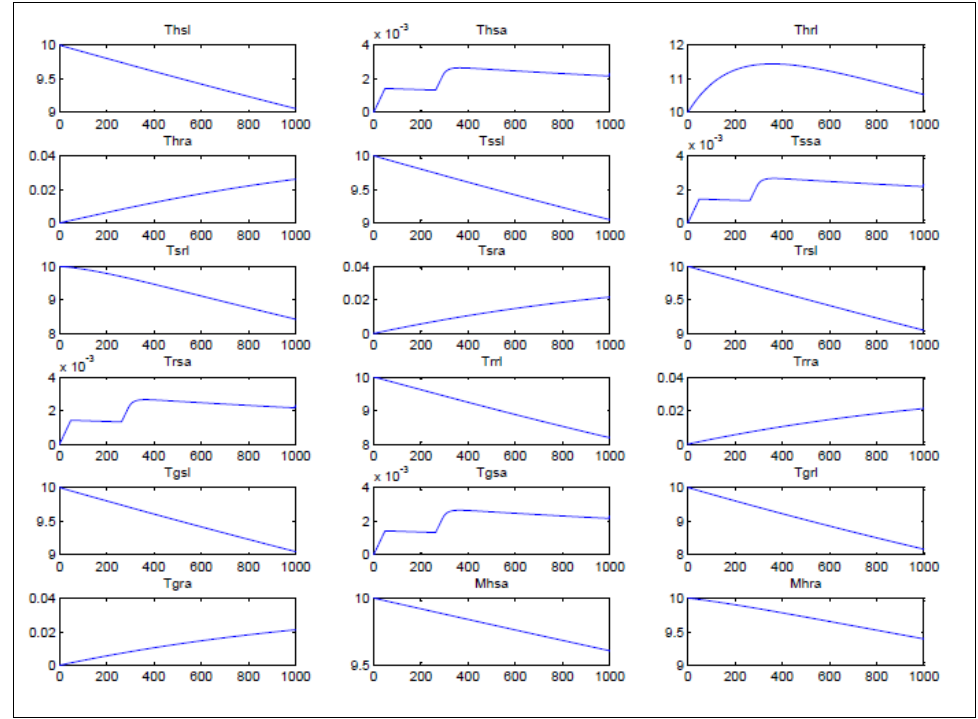
Figure 7. Infected cells dynamics (nonconcave instance).